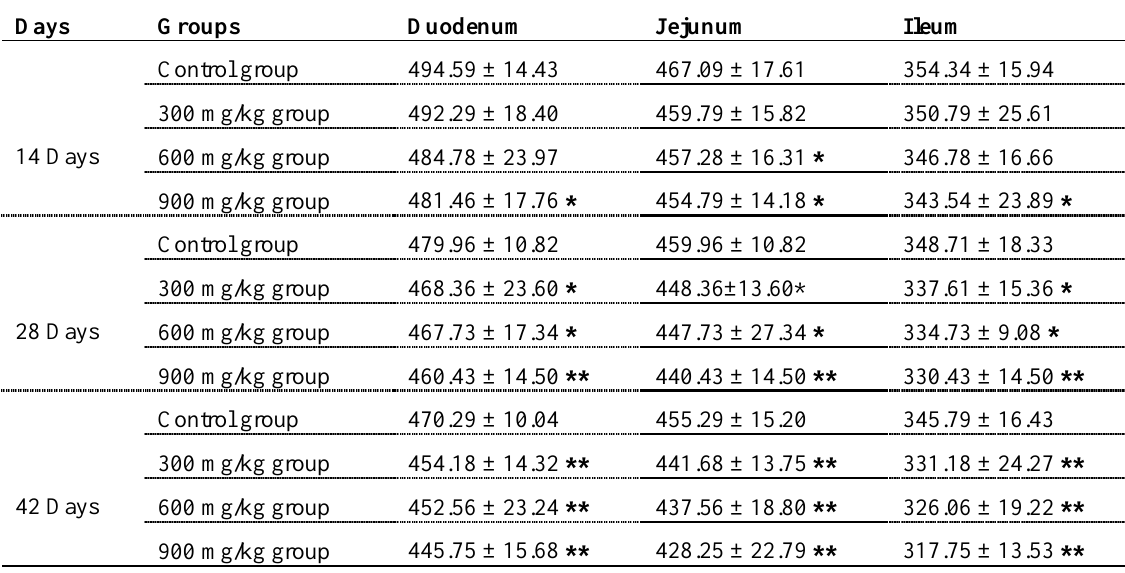
Table 2. Change of the CAT activity (U/gprot) in the intestinal